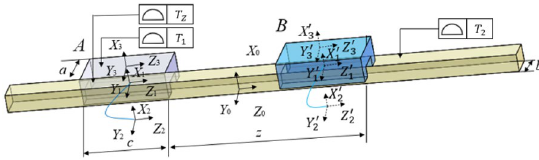
Figure 2 The Z -axis translation motion of CNC machine tool